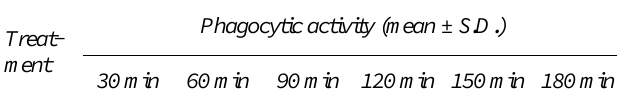
Table 10: Phagocytic activity of head kidney cells from T. nilotica exposed to SlNPV, AcMNPV or AcAaIT.